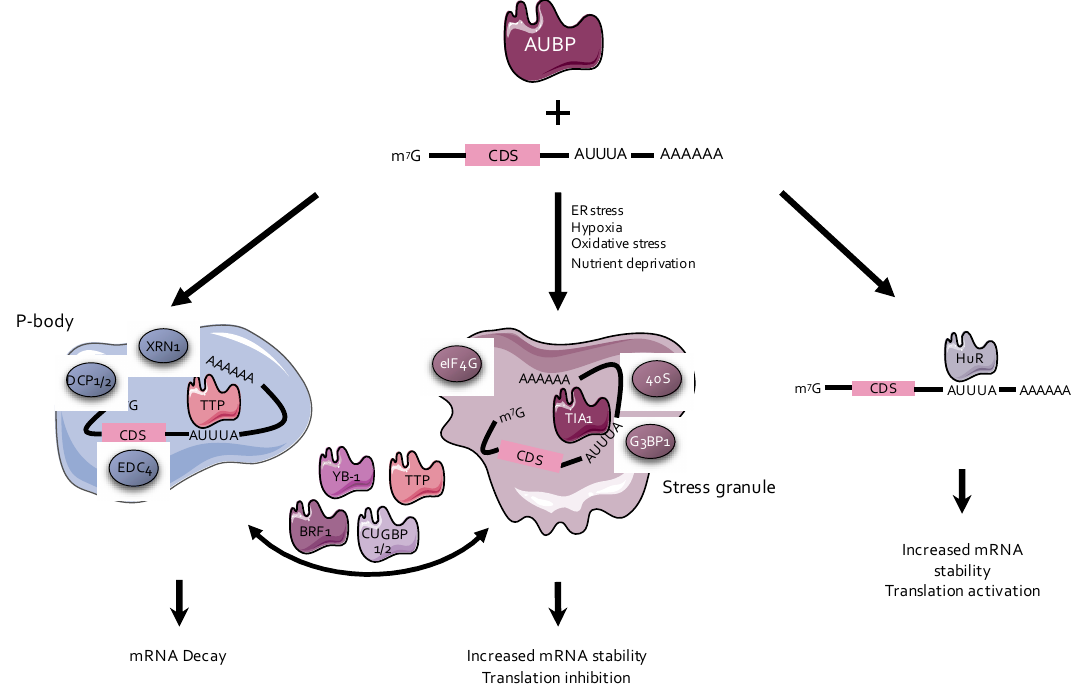
Figure 3. Functions of AU-rich elements-binding proteins (AUBPs). AUBPs associated with processing bodies (P-bodies), such as tristetraprolin (TTP), bind to RNAs and promote their degradation, while AUBPs associated with stress granules (SGs), e.g., T-cell-restricted intracellular antigen-1 (TIA1), inhibit translation and preserve their bound mRNA from degradation. AUBPs can also transfer target mRNA from P-bodies or SGs, or vice versa , to change the fate of targeted transcripts. Other AUBPs, exemplified by Hu-antigen R (HuR), may also bind transcripts, increase their stability, and/or activate their translation. BRF1, butyrate response factor 1; CDS, coding sequence; CUGBP1/2, CUG triplet repeat RNA-binding protein ½; ER, endoplasmic reticulum; YB-1, Y-box-binding protein 1.